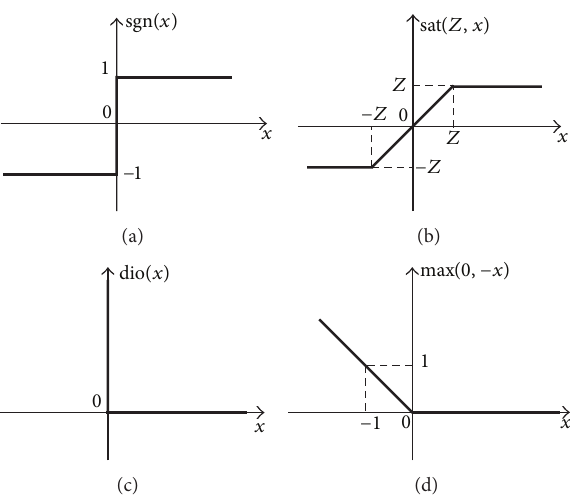
Figure 1: The graphs of relevant functions introduced in Section 2. methods for dry friction and rigid unilateral